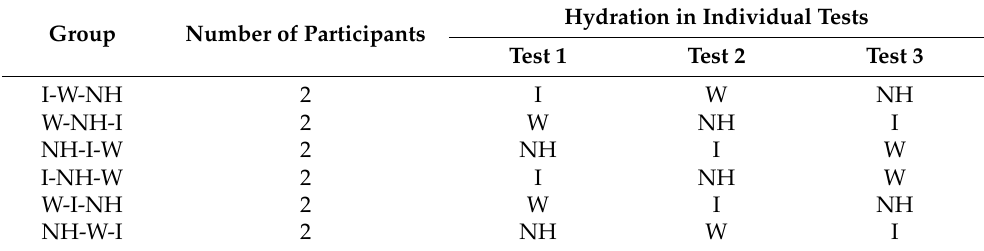
Table 1. Cross-over experimental design, in which tests are performed on six groups of two people at 1-week intervals under three hydration conditions (I—isotonic drinks, W—water, NH—no hydration), with a balanced number of interventions in each of the six possible